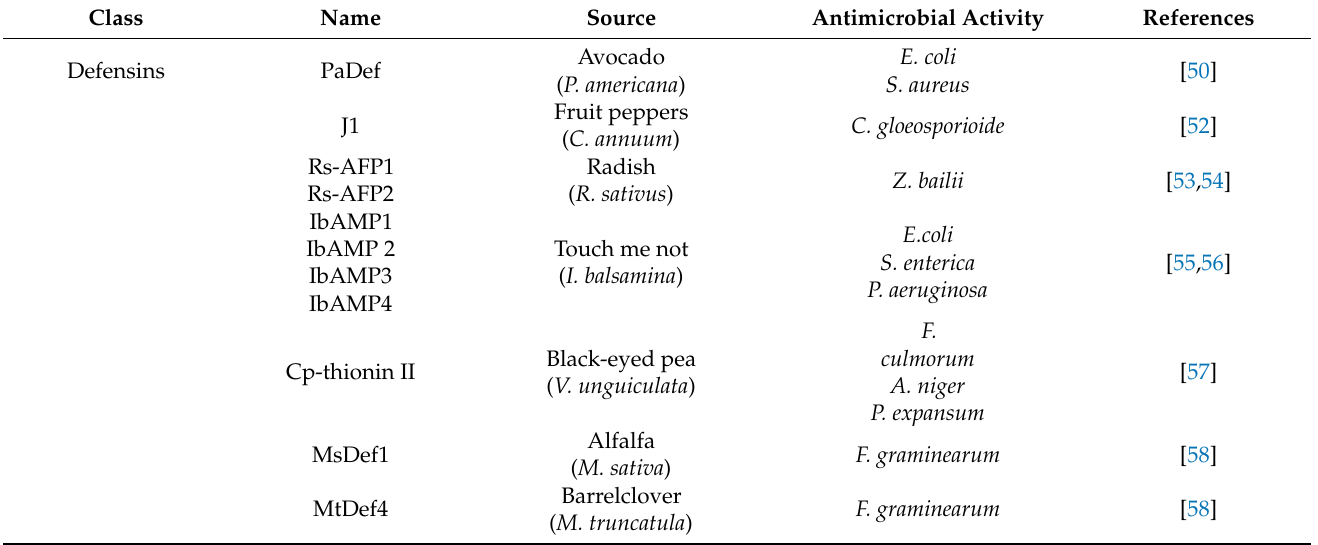
Table 1. Different classes of plant-derived AMPs, sources, and antimicrobial activity. Class Name Source Antimicrobial